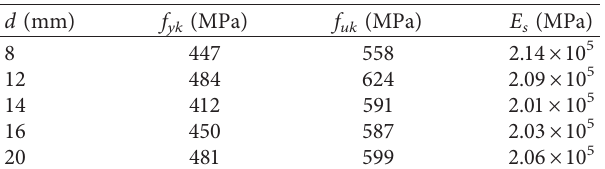
Table 3: Mechanical properties of the steel bar.